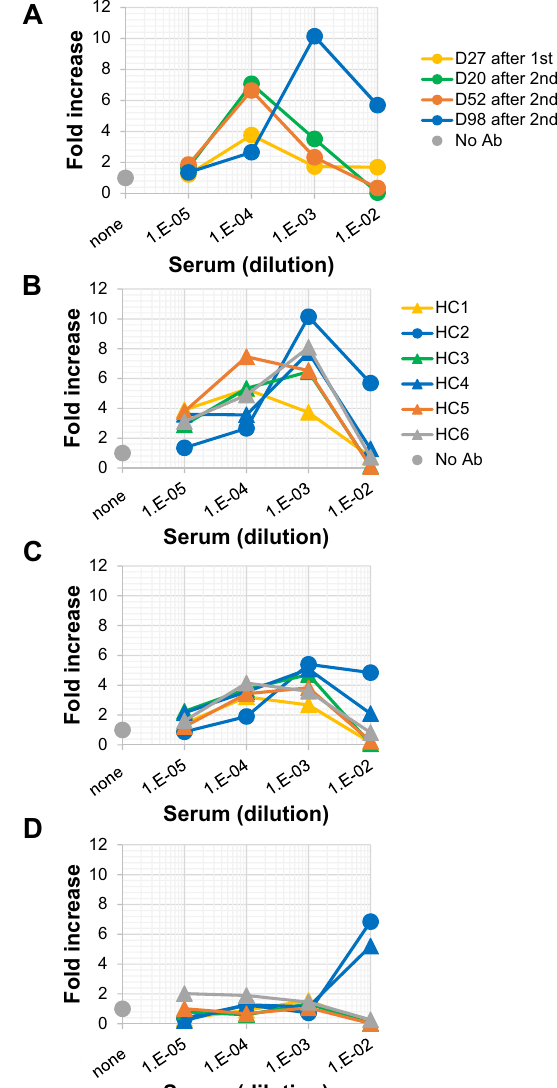
Figure 3. ADE potential in sera collected from mRNA-vaccinated volunteers. ( A ) Clone 35 cells (2 × 10 4 /well in a 96-well flat plate) were cultured with SARS-CoV-2 (original strain, 4 × 10 3 copies/μL) in the presence (N = 3) or absence (N = 3–6, control culture) of serially-diluted sera from the same individual (HC2). Sera were collected at different time points after the first vaccination (on day 27) and second vaccination (on days 20, 52, and 98) as indicated in the insert. ( B – D ) Sera were collected on day 98 ( B ), day 133 ( C ), and day 175 ( D ) after the second vaccination from six healthy control volunteers (HC1-6, see insert in ( B )) and added to the cultures as in ( A ). Three days later, the amount of virus in culture SNs was measured by qPCR. The increase of virus progeny in SNs is expressed as the fold increase compared with the amount of viruses cultured in the absence of serum on a linear scale (this figure) or log scale (Supplemental Fig.